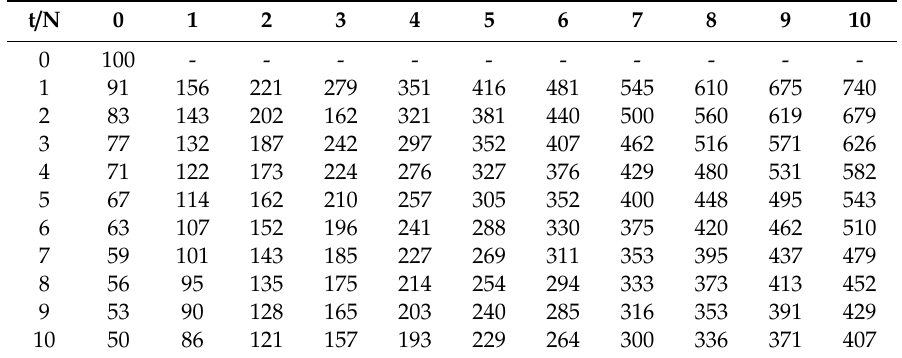
Table 6. Optimal BMS based on the posteriori frequency component (Poisson–gamma